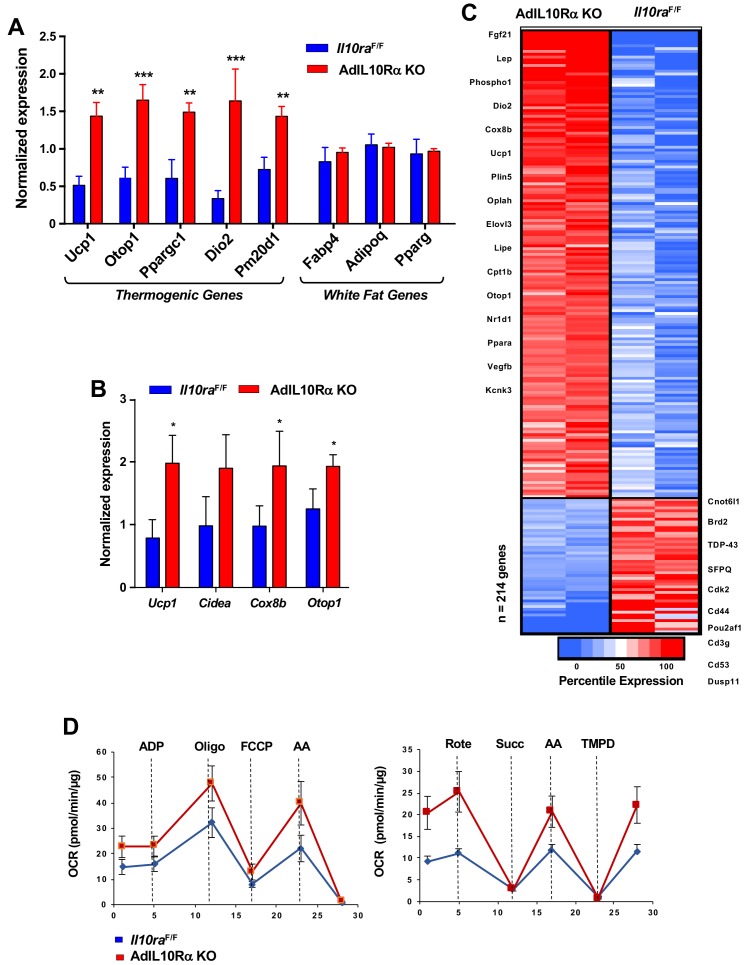
IL10R deficiency promotes adipose tissue browning.(A and B) Real-time PCR analysis of gene expression in iWAT from 10 week 24 hr cold-exposed (A) or CL 1 mg/kg/day for 4 days; B) IL10RαF/F and AdIL10RαKO mice. N = 5,5. *, p<0.05; **, p<0.01; ***, p<0.0001. (C) Heatmap representation of genes that changed >1.5 fold (p-value<0.01) as a function of percentile expression by RNA-Seq of iWAT from 10 week-old 24 hr cold-exposed IL10Rα and AdIL10Rα KO mice. Genes are grouped as upregulated (Red) or downregulated (Blue). (D) Average oxygen consumption rate (OCR) in coupling (left) and electron flow (right) assays of mitochondria isolated from iWAT of mice in (A).